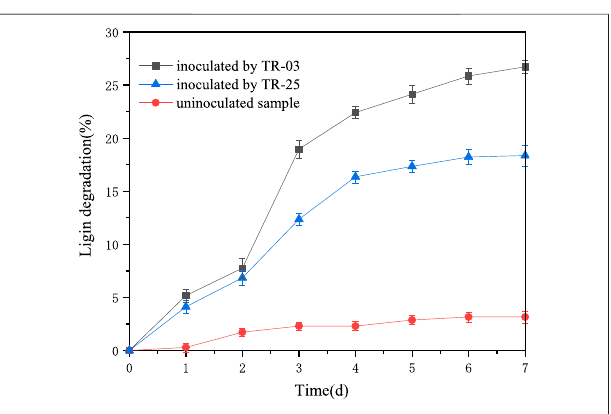
FIGURE4| TimecourseofalkalilignindegradationatA 280 byTR-03and TR-25. Initial concentration of alkali lignin was 2